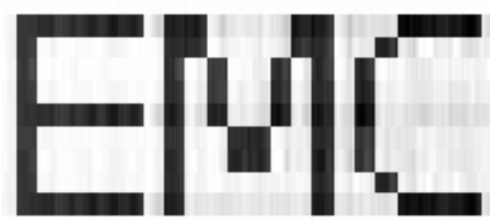
Figure 10. Reconstructed image from common-mode noise 800 × 600 pixels monitor specification.